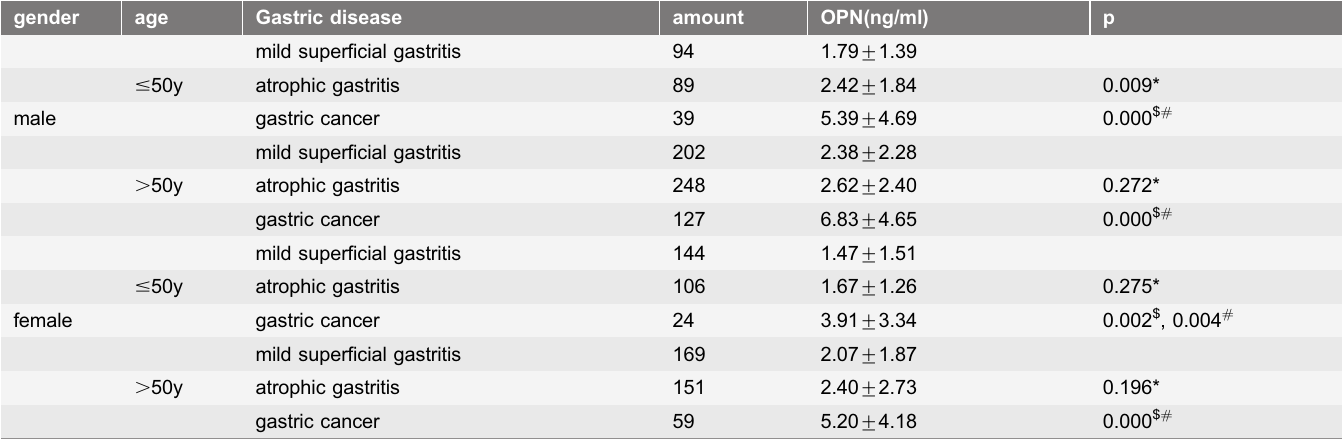
Table 5. Serum OPN expression in gastric diseases, adjusted for age and gender.